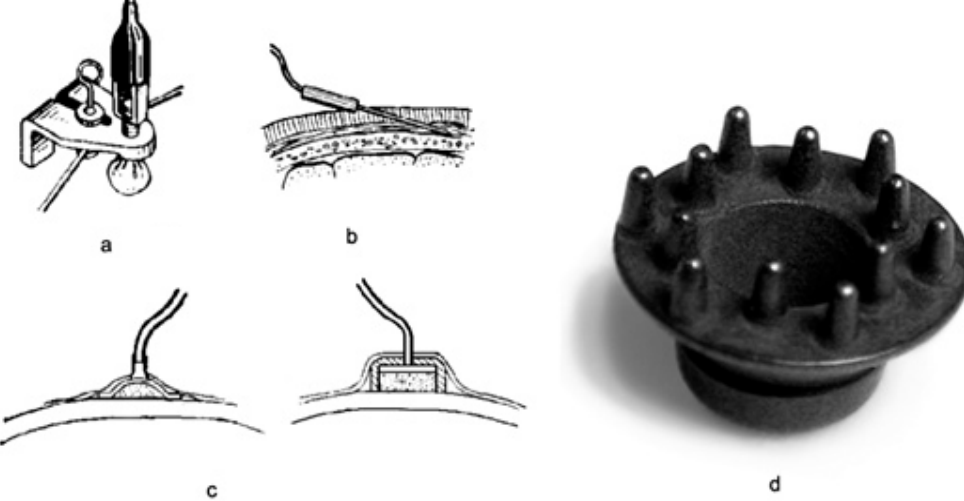
Figure 1. Types of electrodes and how to configure them to acquire useful signals. ( a ) bridge electrode; ( b ) needle electrode; ( c ) cup electrode; ( d ) dry electrode.